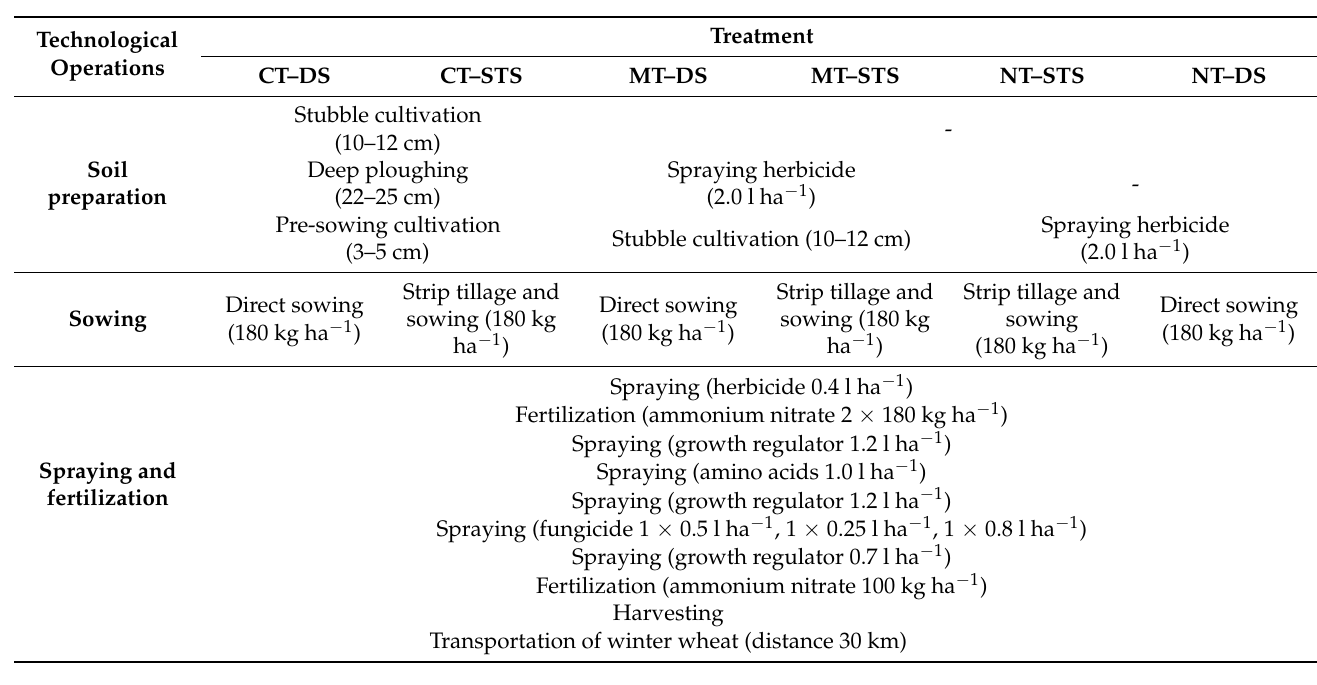
Table 1. Description of winter wheat cultivation technologies using different tillage and sowing